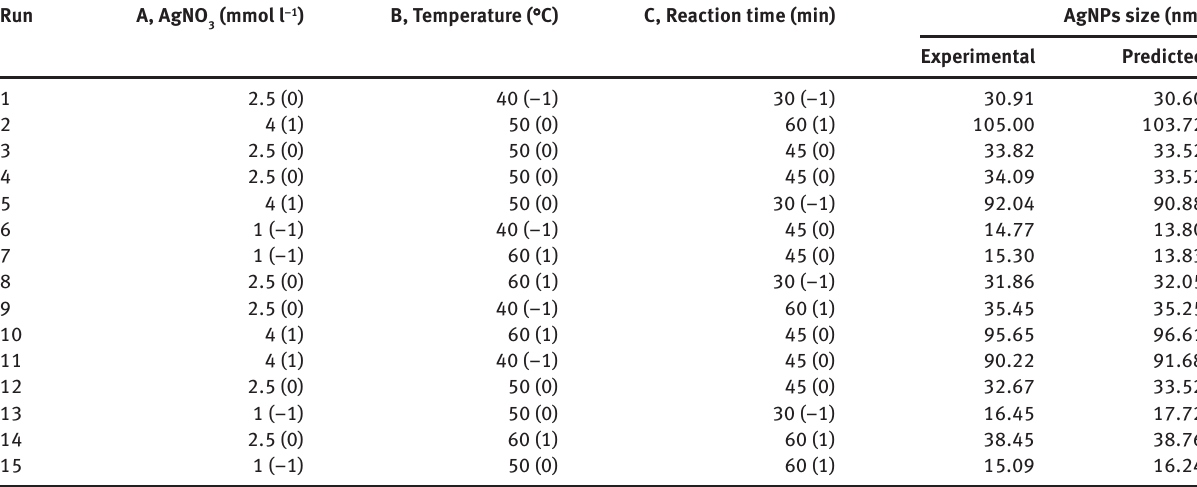
Table 2: Box-Behnken experimental design with natural and coded reaction conditions and experimentally obtained values of AgNPs size.